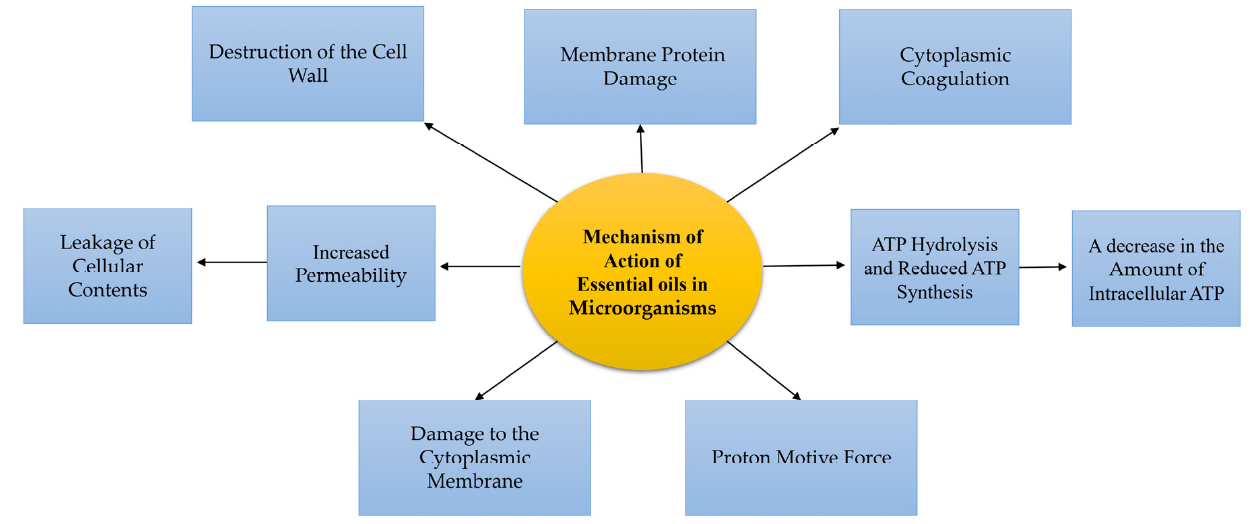
Figure 2. Various types of the mechanisms of the activities of EOs on microorganisms.